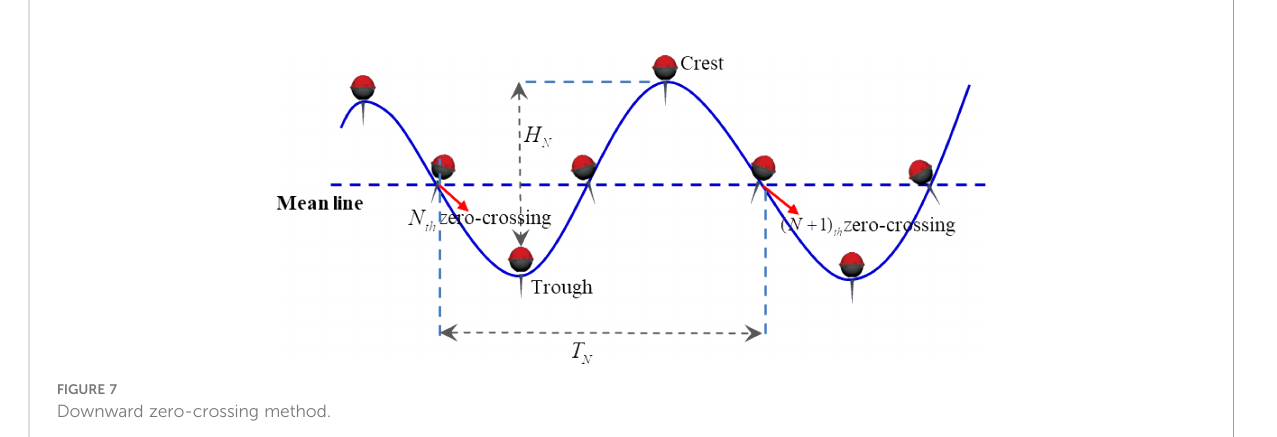
FIGURE 7 Downward zero-crossing